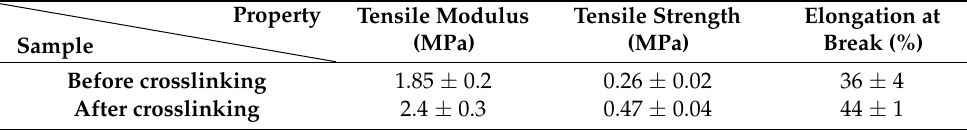
Table 2. The tensile modulus, strength, and elongation at break of the core–shell scaffold before and after